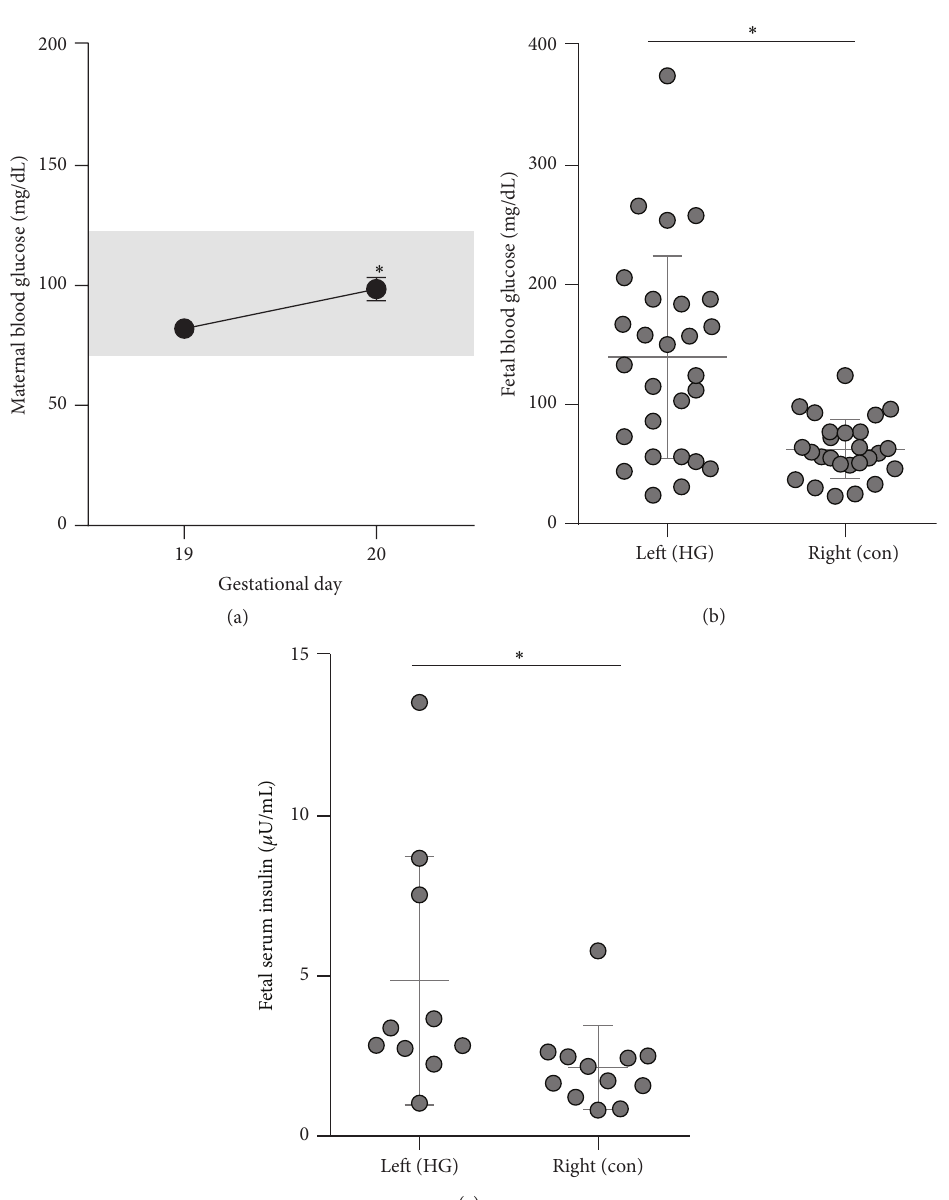
Figure 1: Maternal and fetal glucose and insulin levels. Glucose was infused into the left uterine artery from gestational day 19 until day 20. (a) Maternal blood glucose was measured in the nonfasted state just prior to infusion on gestational day 19 and just before the conclusion of the infusion on gestational day 20. The euglycemic range (70–130) is highlighted on the figure in grey. ∗ 𝑃 < 0.001 by paired 𝑡 -test, 𝑁 = 10 dams. (b) Fetal blood glucose was measured just before the conclusion of the infusion for right-sided (i.e., control, “con”) and left-sided (i.e., hyperglycemia infused, “HG”) fetuses. ∗ 𝑃 = 0.05 by paired 𝑡 -test, 𝑁 = 5 dams, 26-27 fetuses. (c) Fetal serum insulin just before the